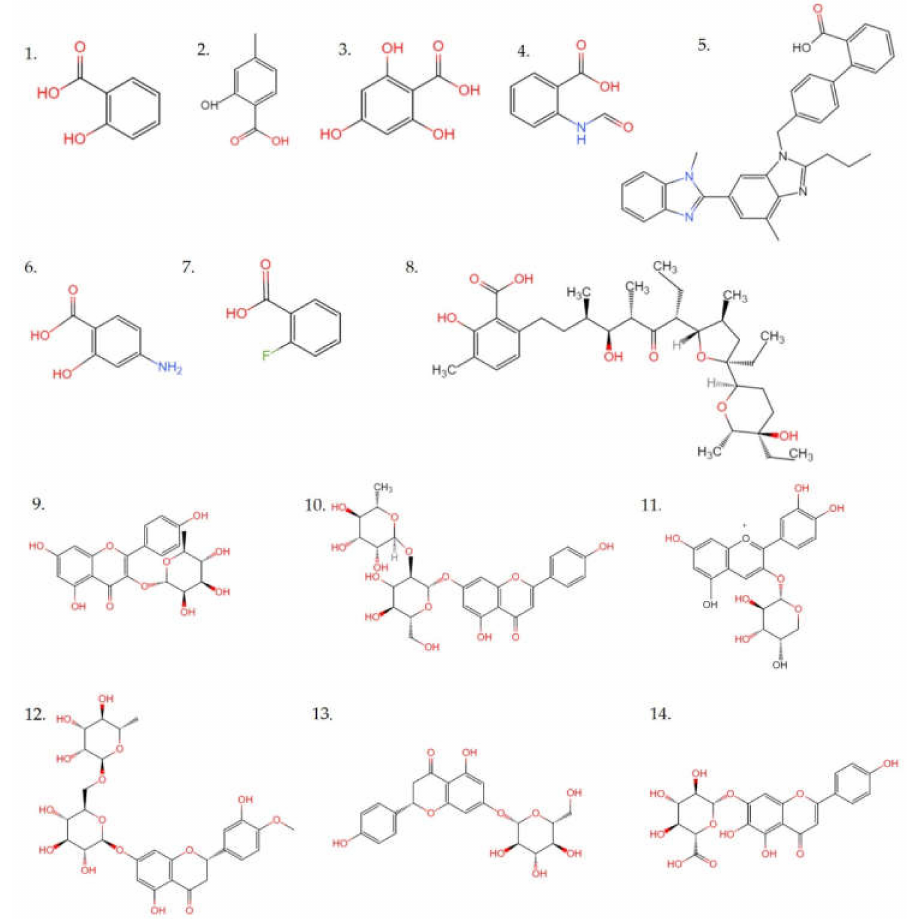
Figure 10. Chemical structures of 14 phenolic acids identified in the fraction of crude extract from quinoa by UPLC-MS/MS. 1 : Salicylic acid; 2 : 2-hydroxy-4-methylbenzoic acid; 3 : Phloroglucinolcar- boxylic acid; 4 : Formylanthranilic acid; 5 : Telmisartan; 6 : 4-Aminosalicylic acid; 7 : 2-Fluorobenzoic acid; 8 : Lasalocid; 9 : Afzelin; 10 : Apigenin-7-O-neohesperidoside; 11 : Cyanidin-3-O-alpha- arabinoside; 12 : Hesperidin; 13 : Naringenin-7-O-glucoside; 14 :